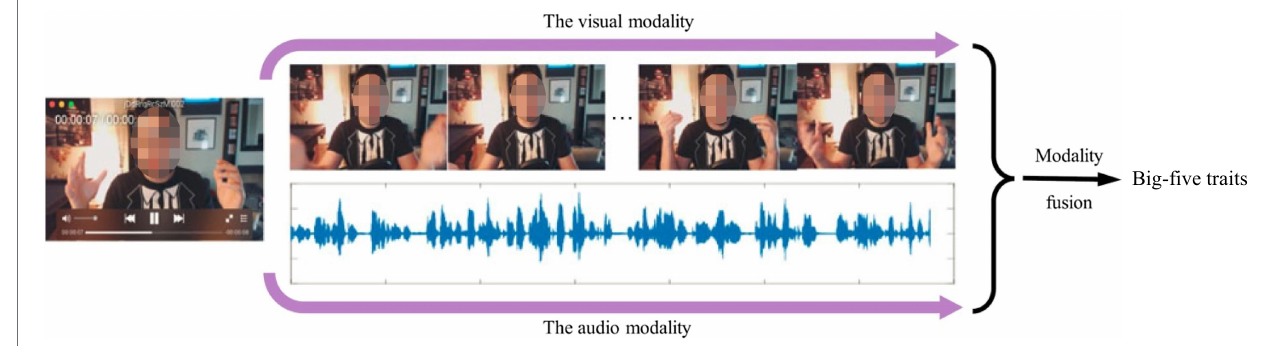
FIGURE 6 | The flowchart of the proposed DBR method for audio-visual personality trait prediction (Wei et al.,